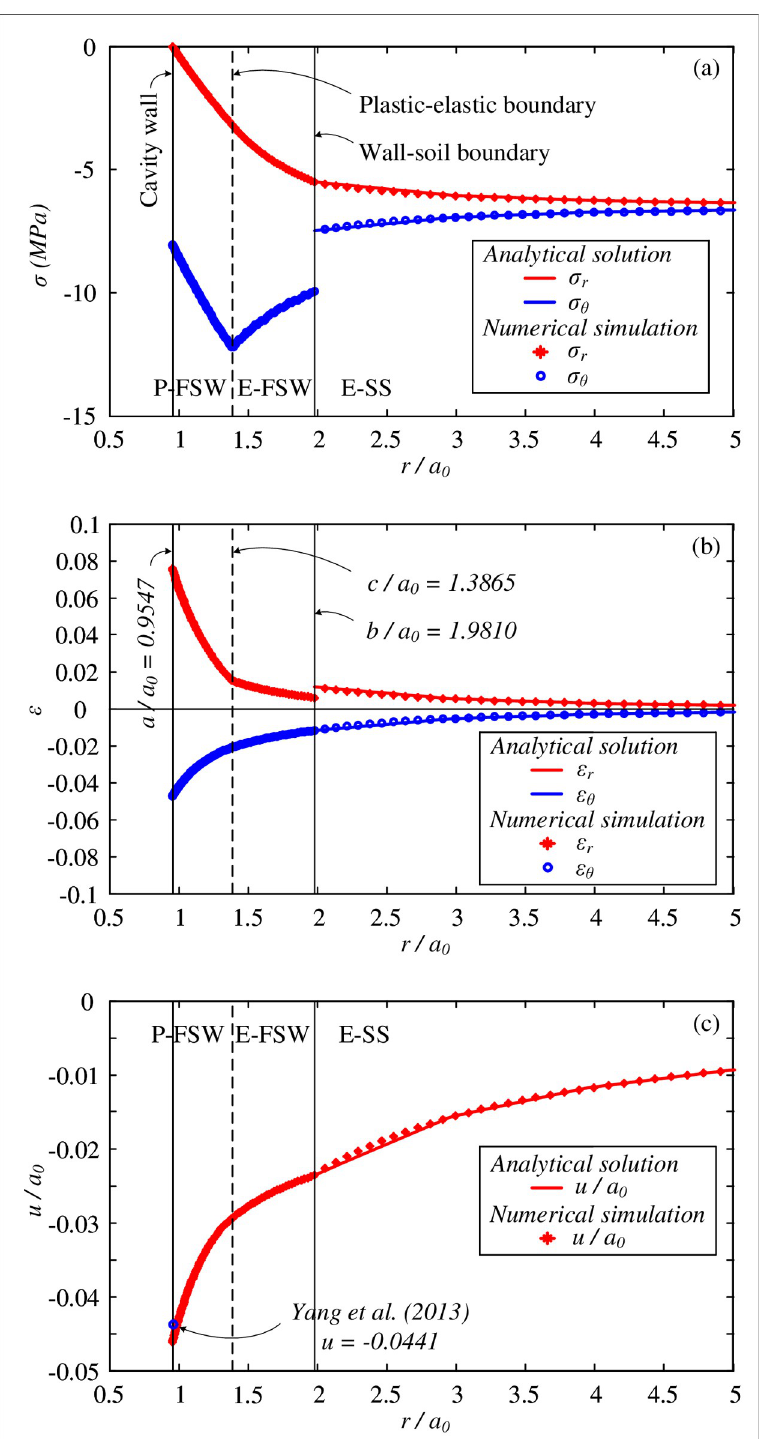
Fig 4. Distributions of (a) stresses; (b) strains; and (c) displacement, with comparisons of numerical simulation.